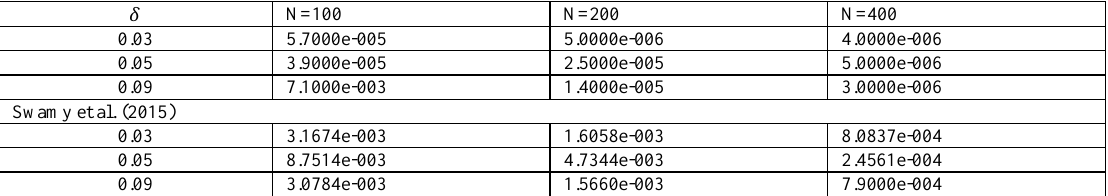
Table 1. The maximum error obtained for 𝜺 =0.1 and for different values of N and 𝜹 for Example 1